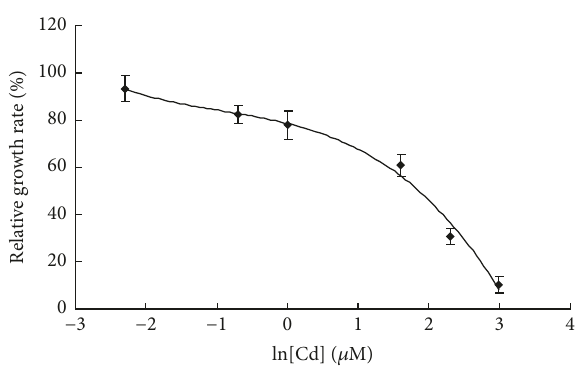
Figure 1: Relative root growth rate (%) as a function of the solution’s Cd concentration ( 𝜇 M).